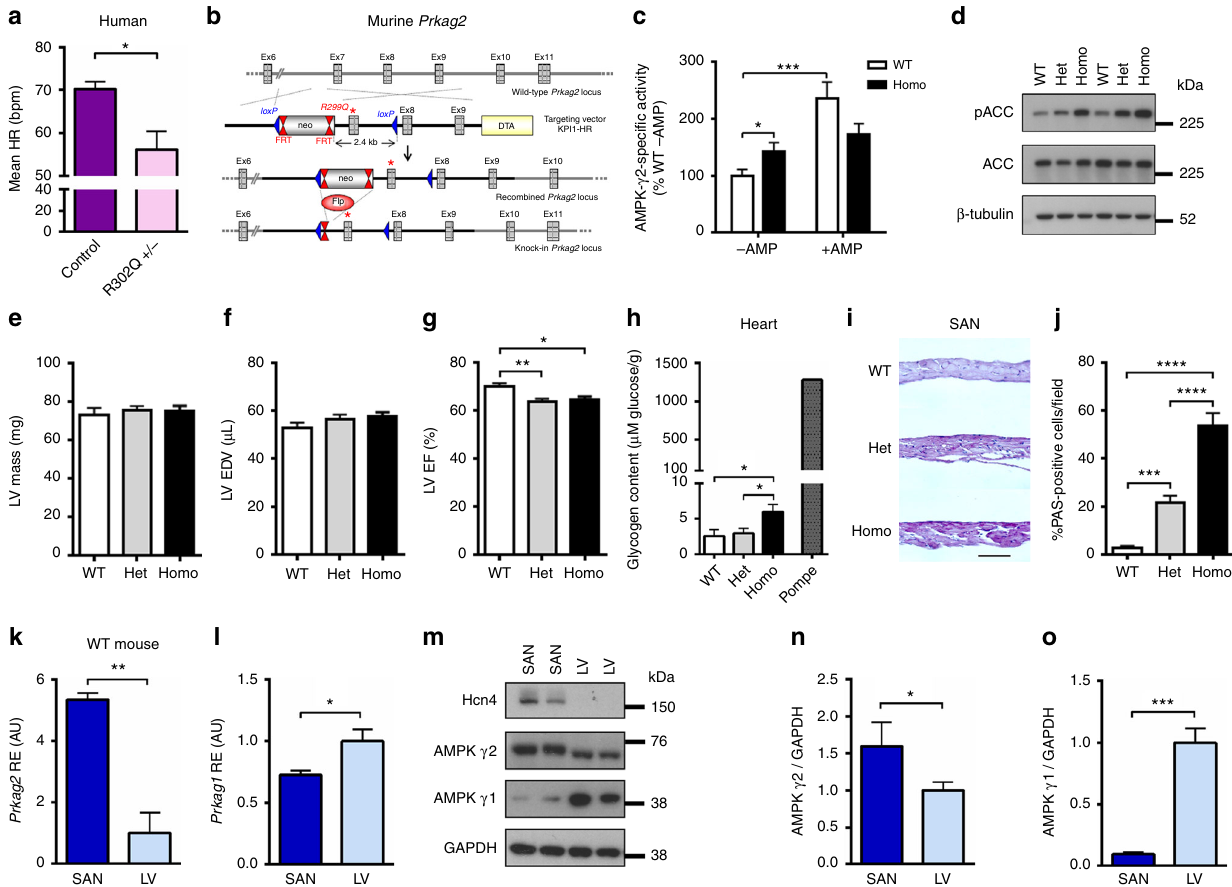
Fig. 1 Generation of the R299Q γ 2 AMPK knock-in mouse and enrichment of γ 2 AMPK in WT SA nodes. a Mean 24-h heart rate (HR) of human heterozygous R302Q γ 2 mutation carriers (age 41.2 ± 2.8 years) vs genotype-negative sibling controls (age 38.9 ± 2.3 years) ( n = 10 – 15). All subjects had any anti-arrhythmic drugs or β -adrenoceptor blockers discontinued for 5 days prior to ECG and none were on amiodarone. b Schematic of gene-targeting strategy to generate the R299Q γ 2 AMPK knock-in. Neo, neomycin selection cassette; FRT, Flp recombinase recognition target; red asterisk denotes mutation in exon 7 of Prkag2 . c γ 2 AMPK-speci fi c activity of freeze-clamped ex vivo perfused hearts measured by SAMS peptide phophorylation assay in the absence or presence of AMP ( n = 18 – 22). d Representative western blot of whole heart tissue from R299Q γ 2 and WT mice for phospho-(p) ACC ( n = 11 – 15). e – g Cine MRI analysis of left ventricular (LV) mass ( e ), end-diastolic volume (EDV) ( f ) and ejection fraction (EF) ( g ) in R299Q γ 2 and WT mice aged 2 months ( n = 8 – 19). h Cardiac tissue glycogen content from 12 month R299Q γ 2 and WT mice together with a positive control heart from a homozygous Gaa (encoding acid α -glucosidase) knockout mouse ( n = 12 – 15). i , j Periodic acid-Schiff (PAS) staining ( i ) (scale bar, 5 µ m) and quanti fi cation of glycogen content ( j ) (as %PAS-positive cells/ fi eld) of SA node (SAN) sections ( n = 12). k , l Quantitative real-time PCR (qRT-PCR) of γ 2 and γ 1 AMPK isoform relative gene expression levels (normalized to β -actin) from normal murine SA node and LV (SAN, n = 4; LV, n = 10). m – o Western blot ( m ) and densitometry ( n , o ) of γ 2 and γ 1 AMPK in normal murine SA node and LV, together with SA node positive (HCN4) and loading (GAPDH) controls ( n = 6 – 8). Uncropped western blots are shown in Supplementary Fig. 10. a , k , l , n , o Student ’ s t -test was performed. c Kruskal – Wallis test followed by Dunn ’ s multiple comparisons test was performed. e – h , j One-way analysis of variance (ANOVA) followed by Holm – Sidak ’ s multiple comparisons test was performed. * P < 0.05, ** P < 0.01, *** P < 0.001, **** P < 0.0001. RE relative expression, AU arbitrary units. a , c , e – h , j – l , n , o Data are shown as means ±